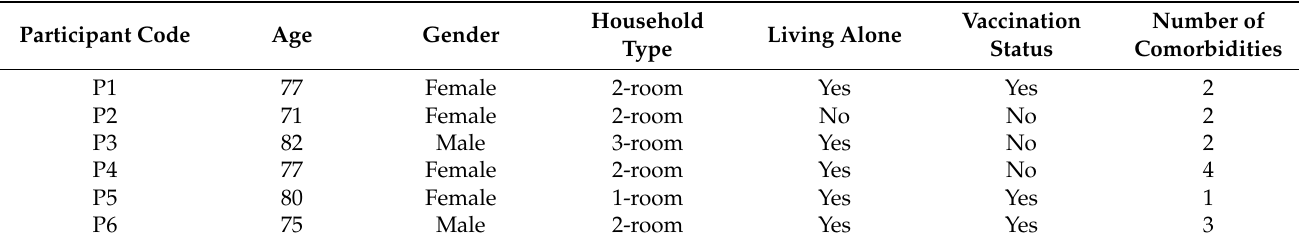
Table 7. Interview participants (N =